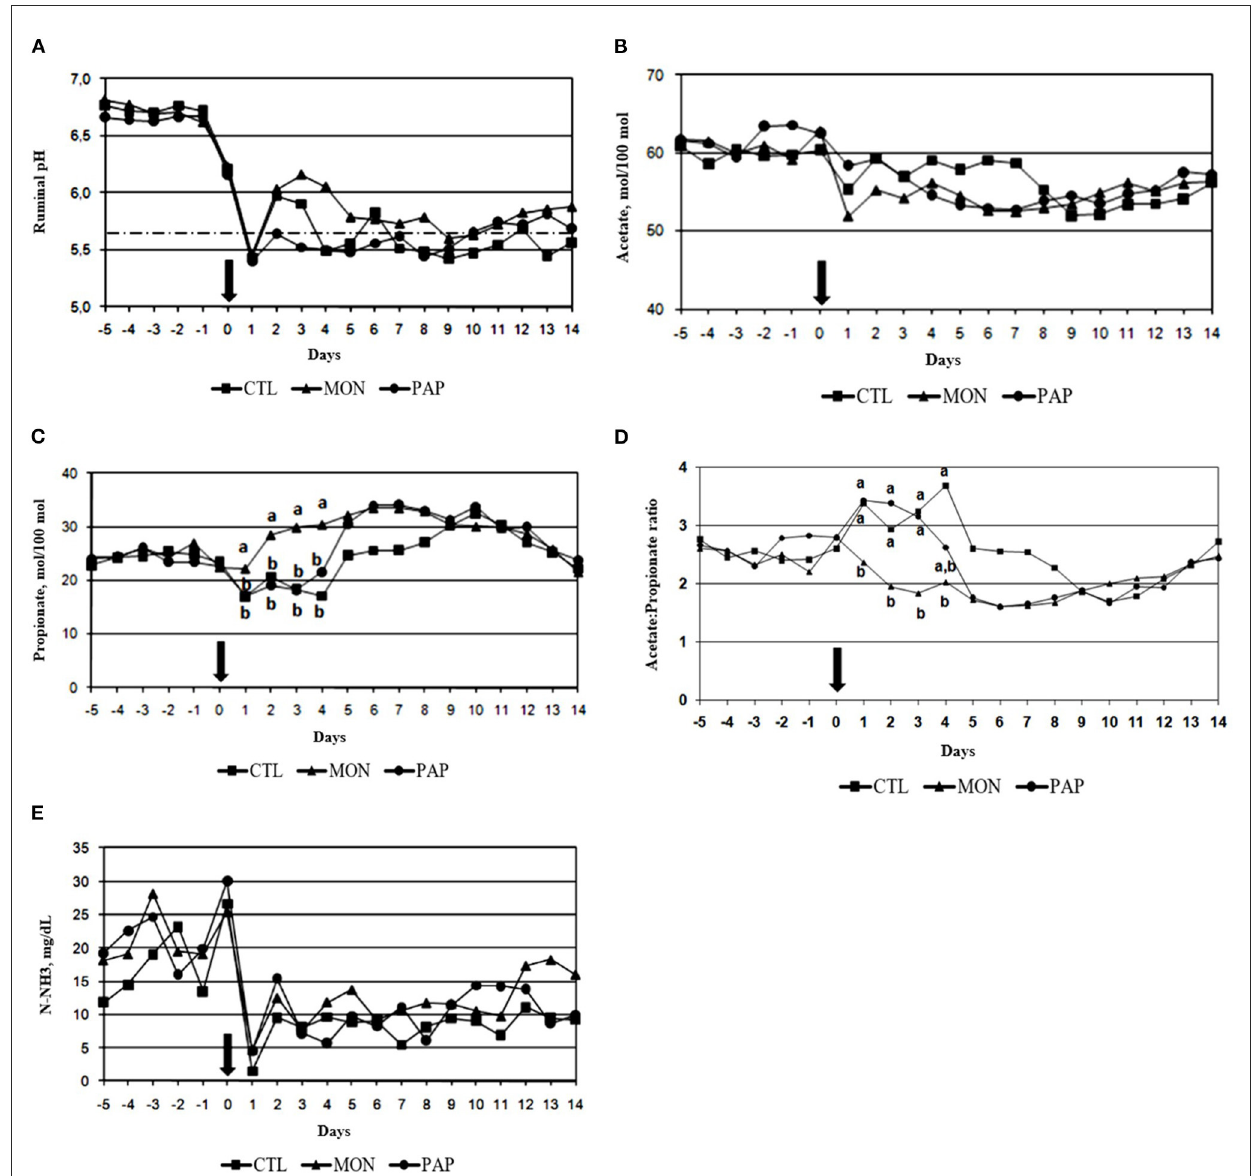
FIGURE2 Ruminal pH (A) , acetate [% molar proportion, (B) ], propionate [% molar proportion, (C) ], acetate: propionate ratio (D) , and N-NH3 concentration (E) of cows induced to ruminal acidosis receiving polyclonal antibodies (PAP) or monensin (MON). The bold arrow represents the change from the 100% forage diet to the 74% concentrate diet containing the